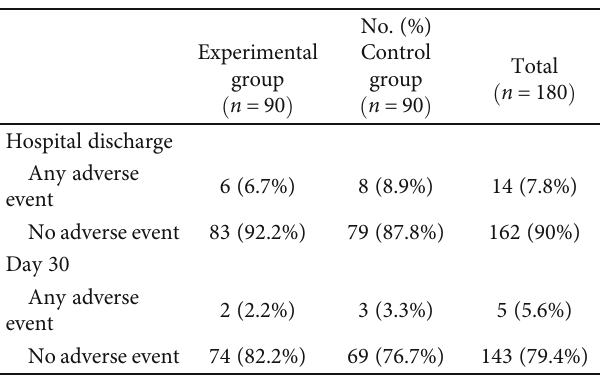
Table 5: Adverse events.